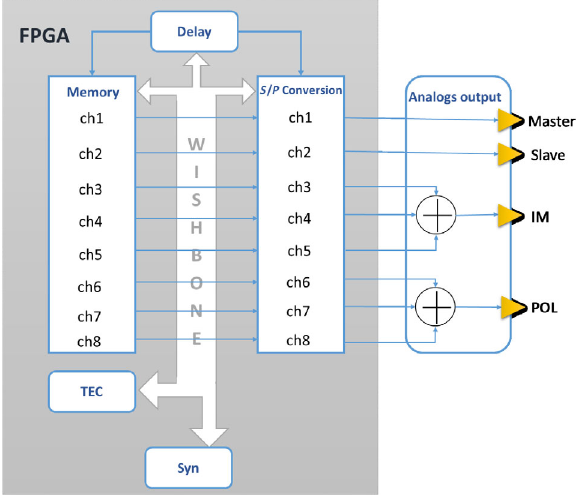
FIG. 11. Architecture of the electronics board. The dash box denotes a FPGA, which can be divided into several